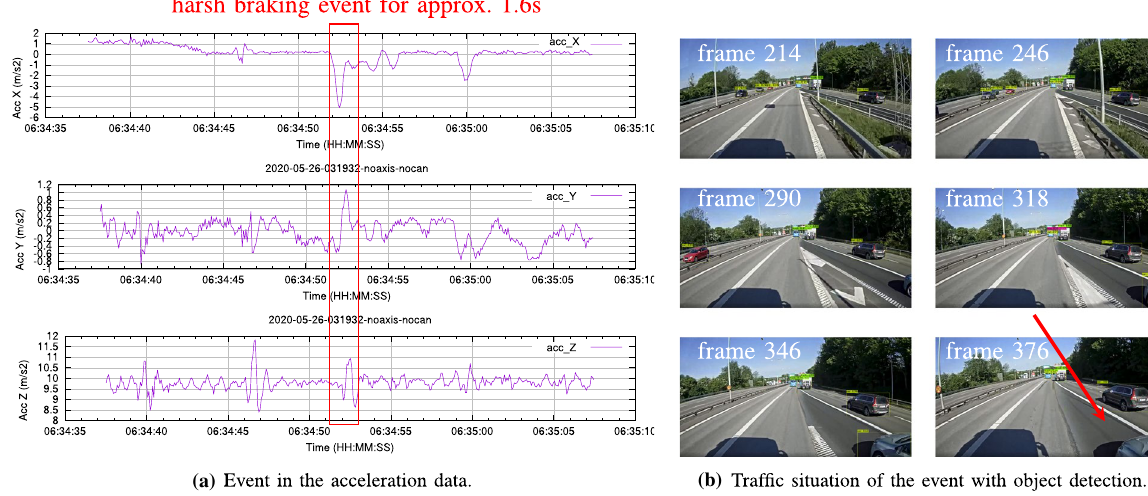
Fig. 2 Event where the truck was forced to conduct an unintended deceleration maneuver; no collision happened